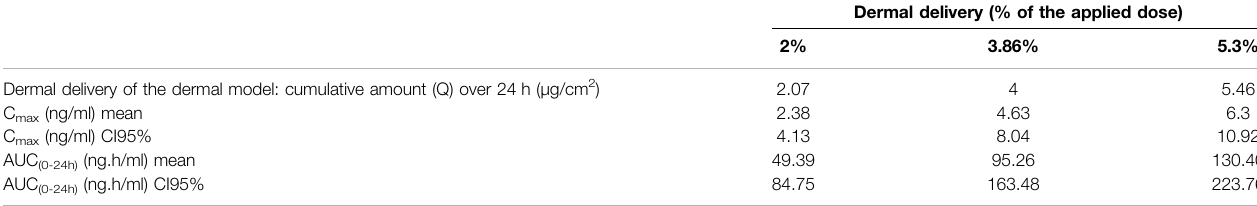
Dermal delivery (% of the applied dose)